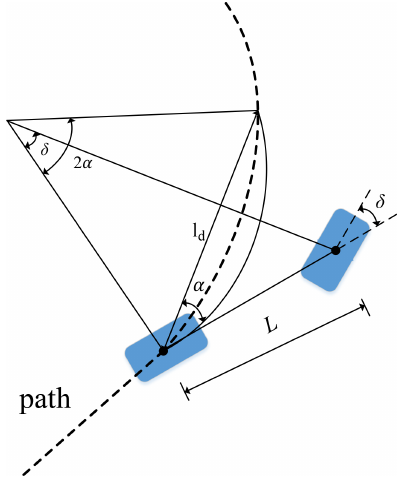
Figure 2. The pure pursuit method.